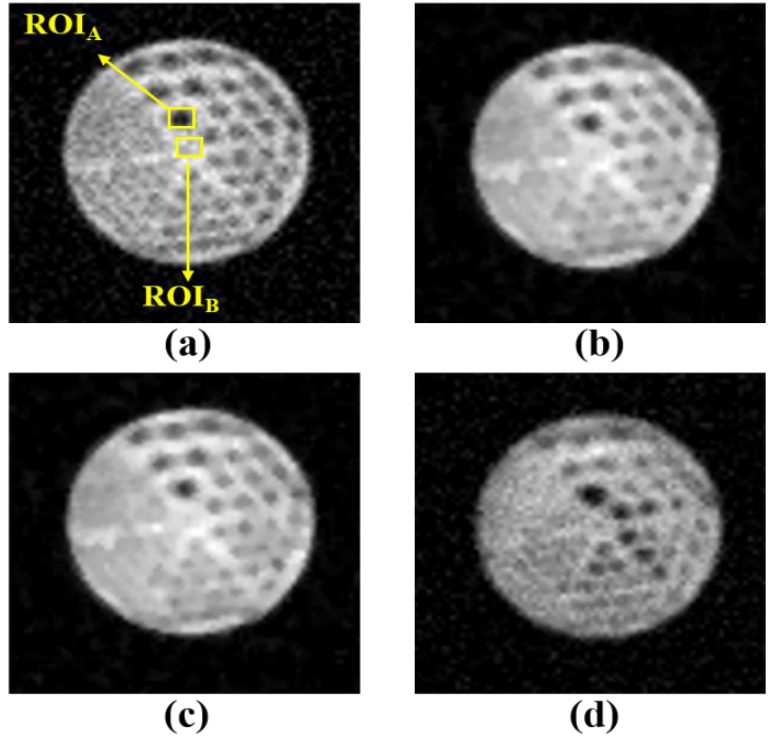
Figure 4. MR-AC Dixon-GRAPPA -based PET phantom images with ( a ) noise, ( b ) Wiener filter, ( c ) median filter, and ( d ) TV algorithm. The contrast-to-noise ratio (CNR) was calculated using the ROI A and ROI B , and the coefficient of variation (COV) was calculated using the ROI A .